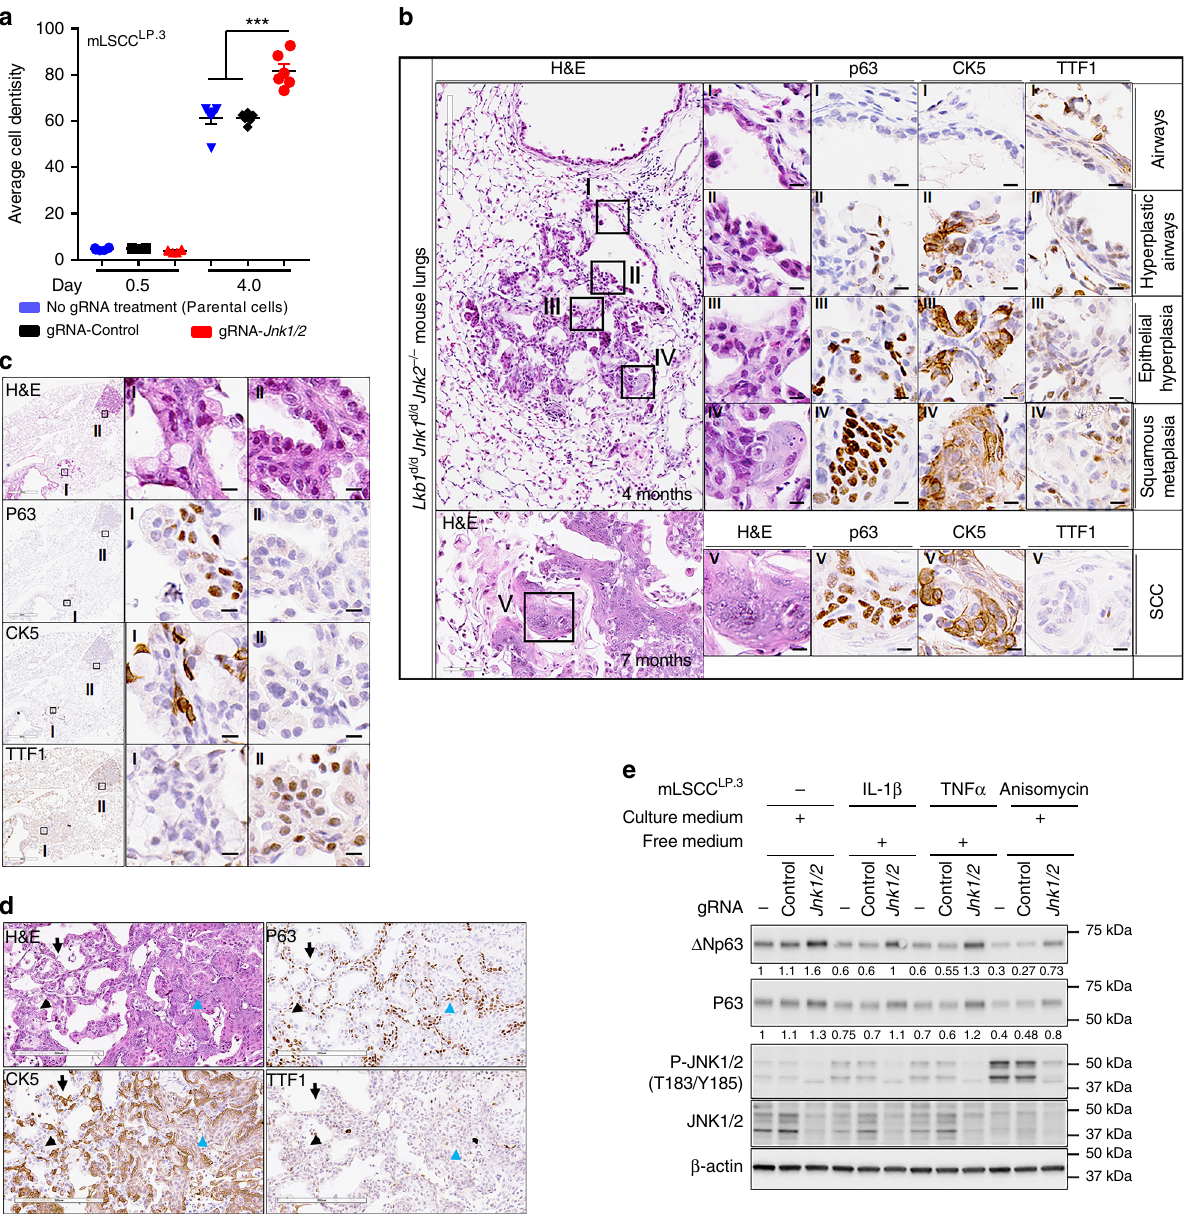
Fig. 4 Jnk1/2 ablation accelerated Lkb1 -de fi ciency-induced LSCC progression. a Quanti fi cation of cell colony formation assay of mLSCC LP.3 cells after knockout of Jnk1/2 or scramble (Control) using Lentiviral Cas9/gRNA. Error bar is SEM; T test: *** P < 0.001. b Representative H&E and IHC staining of 4-month-old (4M) and 7-month-old (7M) CCSP iCre Lkb1 f/f Jnk1 f/f Jnk2 − / − ( Lkb1 d/d Jnk1 d/d Jnk2 − / − ) mouse lungs. SCC markers: p63 and CK5; AD marker: TTF1. Scale bar: 600 μ m (black box, 4 months), 60 μ m (black box, 7 months), and 10 μ m (solid black). c Representative H&E and IHC staining of 7-month- old Lkb1 d/d Jnk1 d/d Jnk2 − / − mouse lung epithelial hyperplasia (I), and adenocarcinoma (II). Scale bar: 300 μ m (black box, left panel), 60 μ m (black